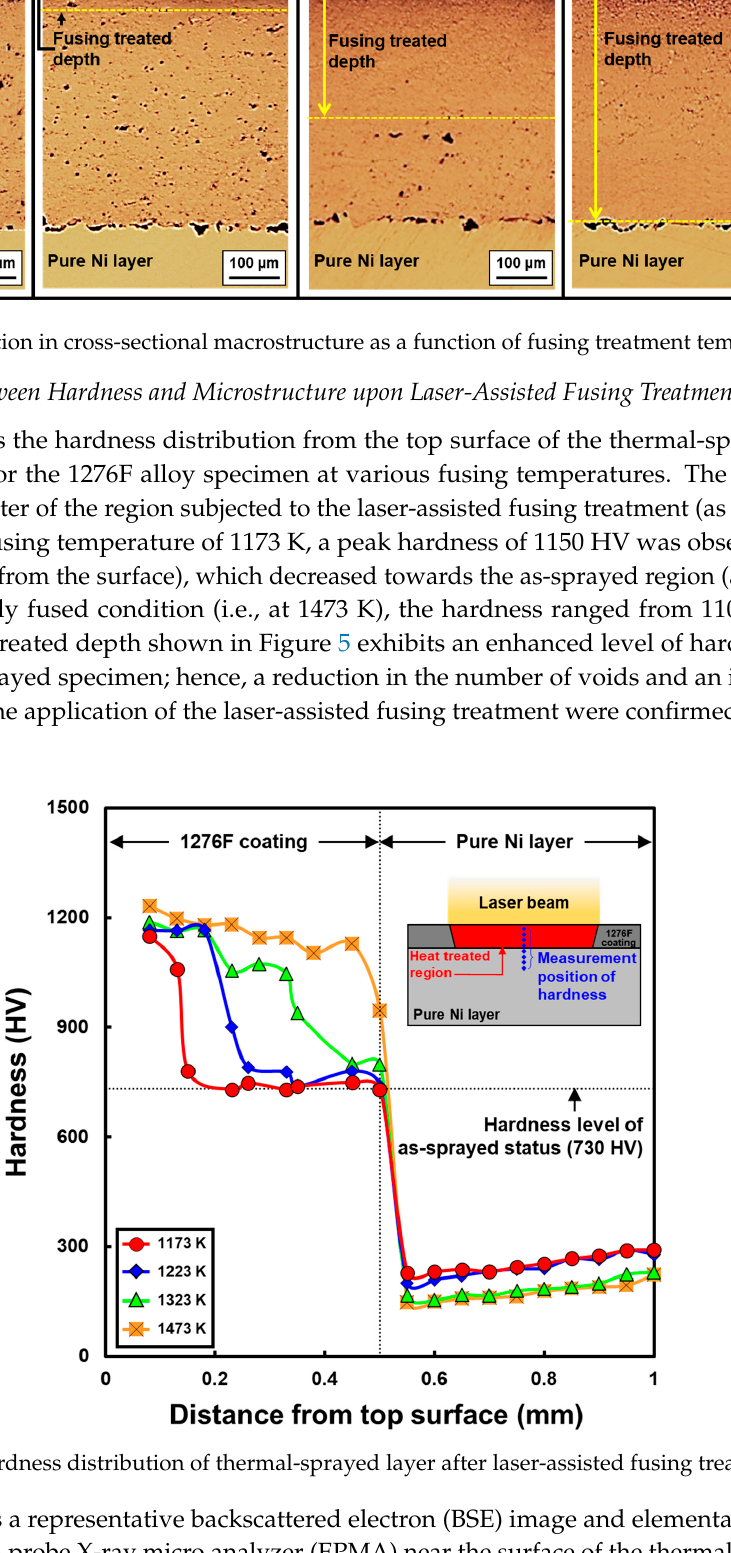
8 of 17 Figure 4. ( a ) Macrostructure and ( b ) element distribution obtained by EPMA analysis (from “A” region in Figure 4a) of the thermal-sprayed layer of the as-sprayed specimen. 4.2. Homogenization Behavior upon Laser-Assisted Fusing Temperatures Figure 5 shows a representative variation in the cross-sectional macrostructure to illustrate the